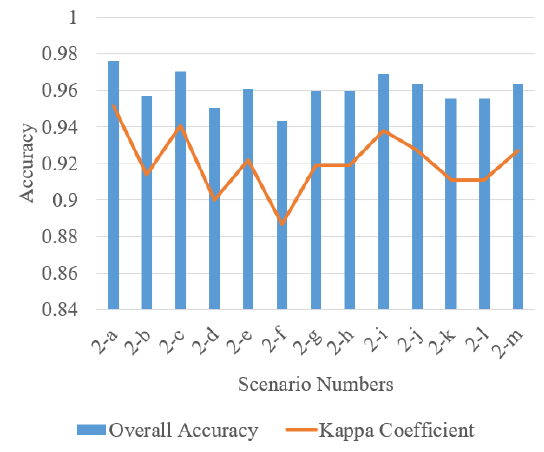
Figure 9. Overall Accuracy and Kappa Coefficient of the second series of